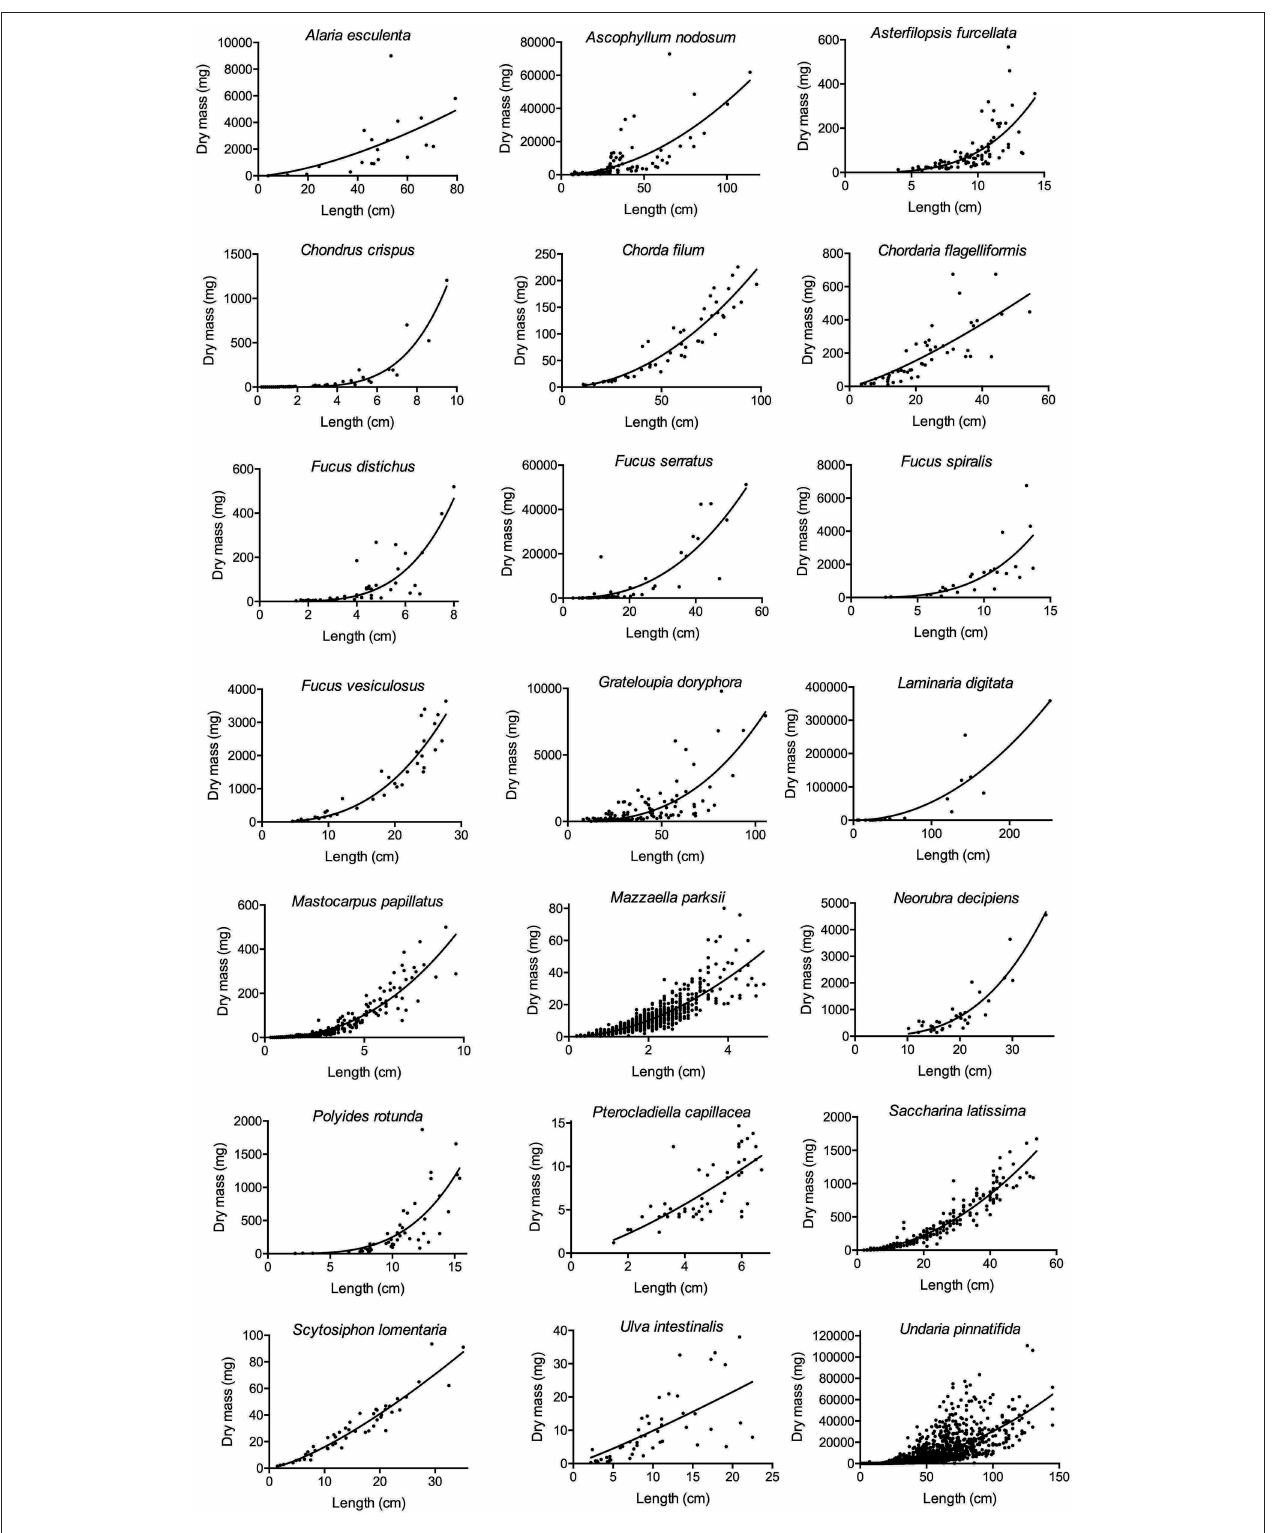
FIGURE 1 | Allometric relationships between length (cm) and dry biomass (mg) for the 21 studied seaweed species.